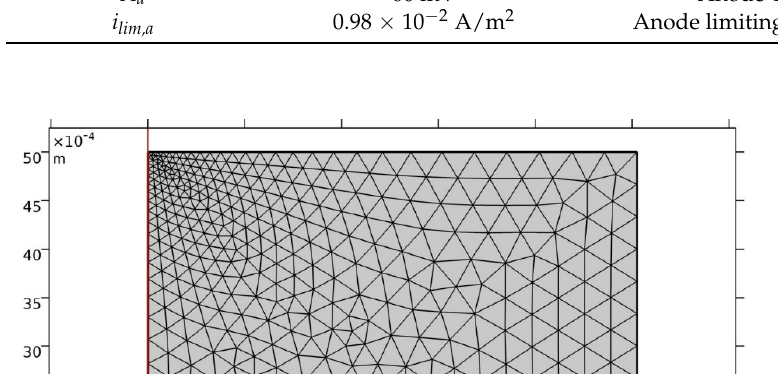
Table 1. Summary of Tafel slopes and current densities found in the literature.